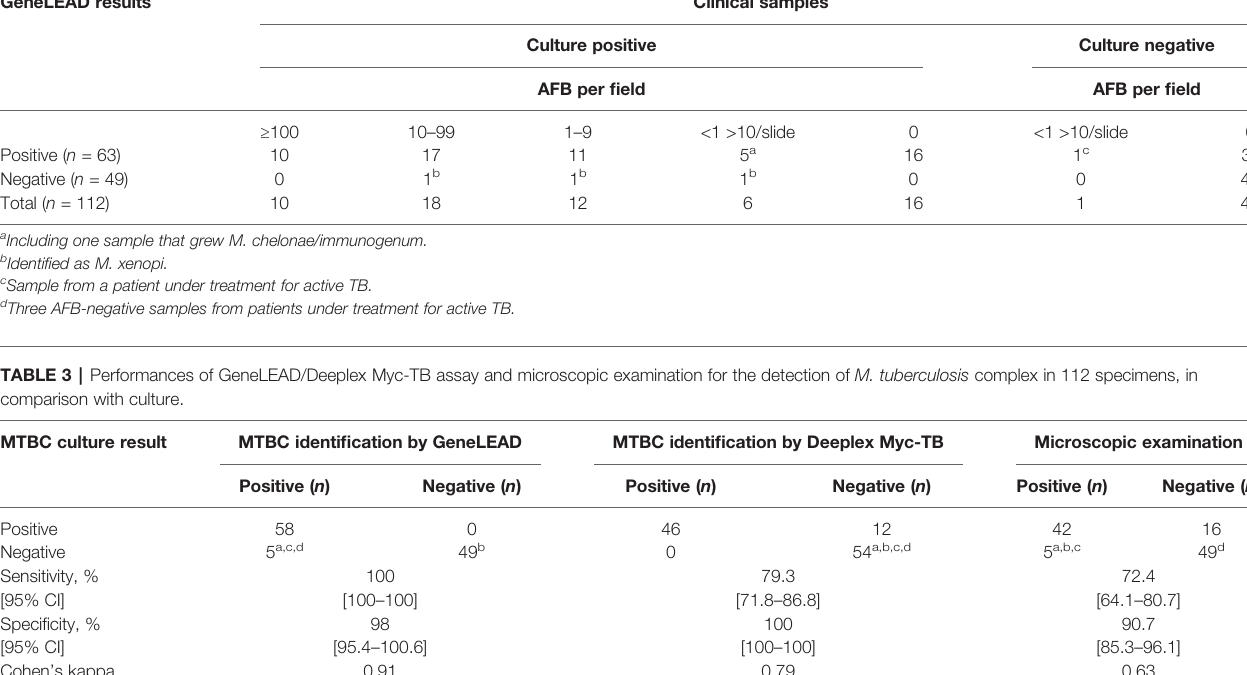
TABLE 2 | Summary of the GeneLEAD results on clinical samples. GeneLEAD results